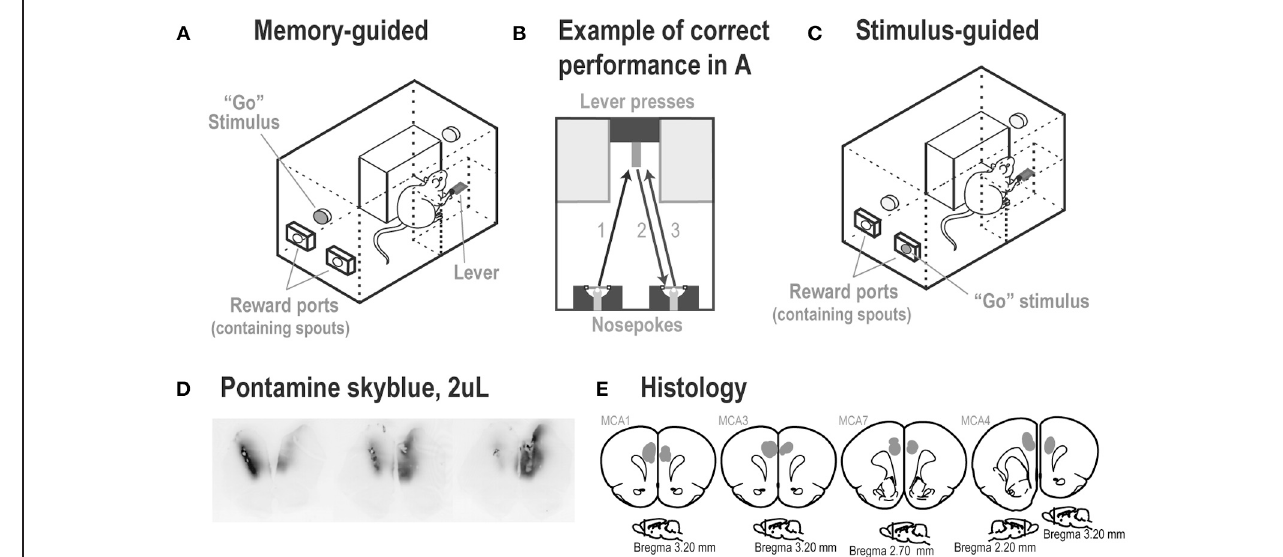
infusion in the right hemisphere is shown in the right brain section. The center image was located between the two infusion sites. Note that the dye was retained within the medial prefrontal cortex. (E) Locations of infusion sites based on reconstructions of tissue dispersion patterns (shown as gray shaded areas) at the end of the tracks made by the guide cannula. In each rat, the cannula ended within the medial prefrontal cortex (Cg1/PrL areas). (Images are based on Paxinos and Watson,